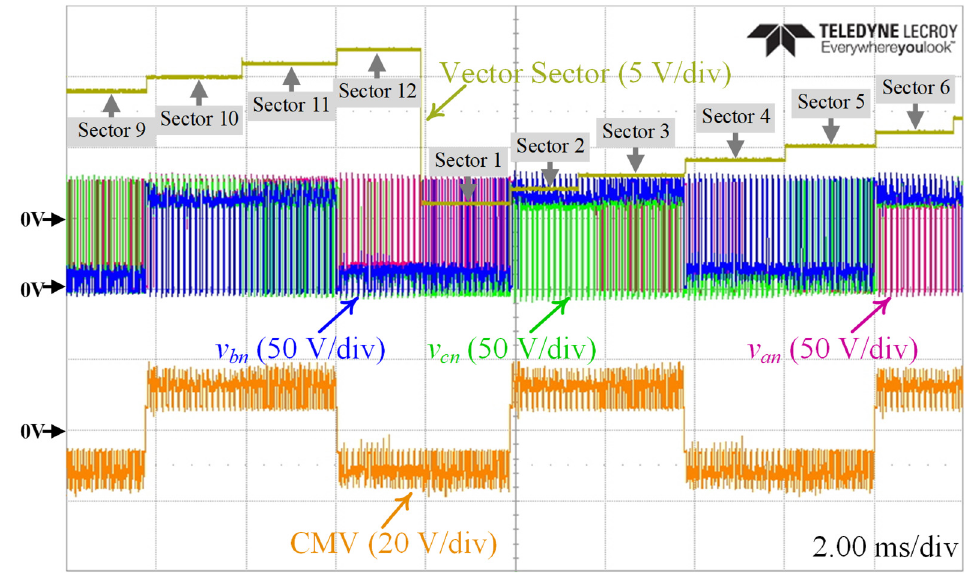
Figure 19. Experimental results of vector sector, three-phase pole voltage, and CMV at rated load current and rotor speed of 500 rpm.